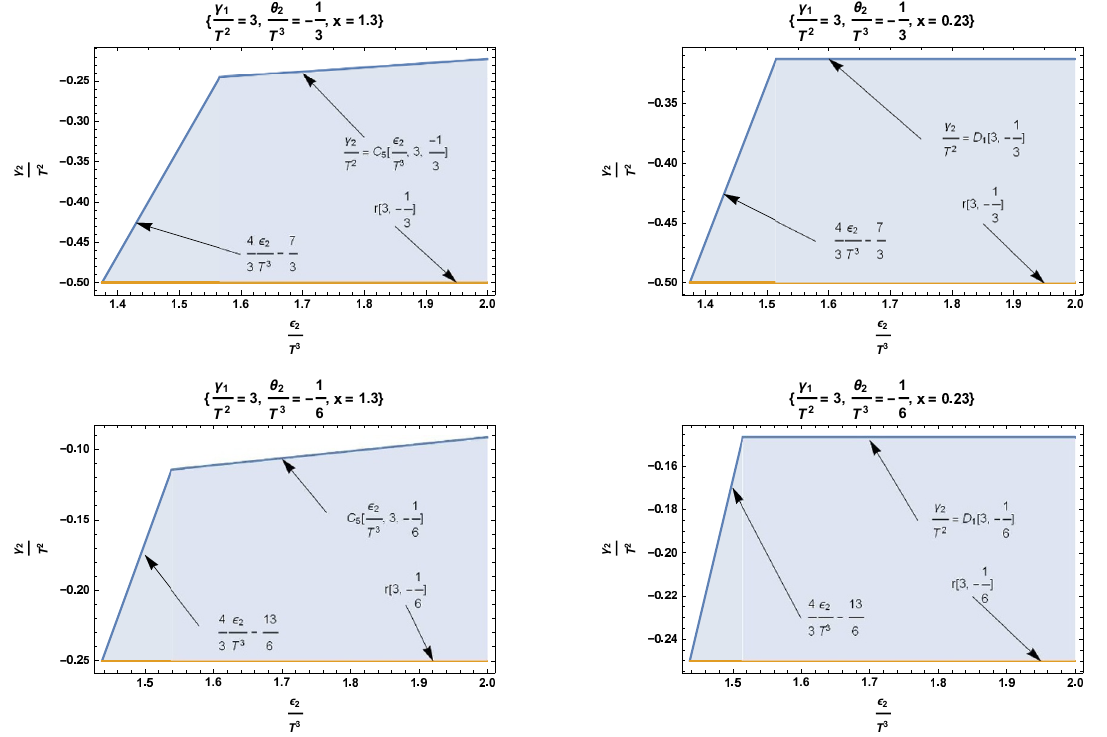
Figure 6 . Acceptable zones in the case of finite µ 0 and T 0 . Boundaries are given in terms of table 1 data. From top-left to bottom right figure the areas are 0.14, 0.10, 0.07 and 0.05, respectively.